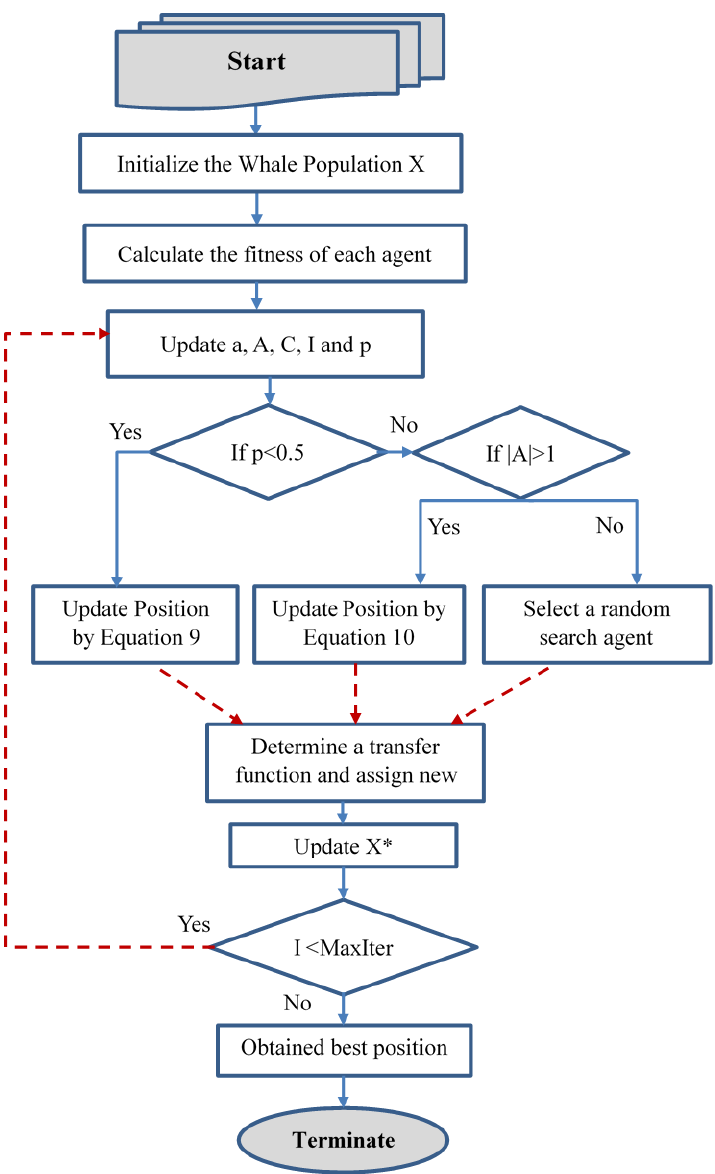
Figure 1. Binary whale optimization algorithm flowchart.